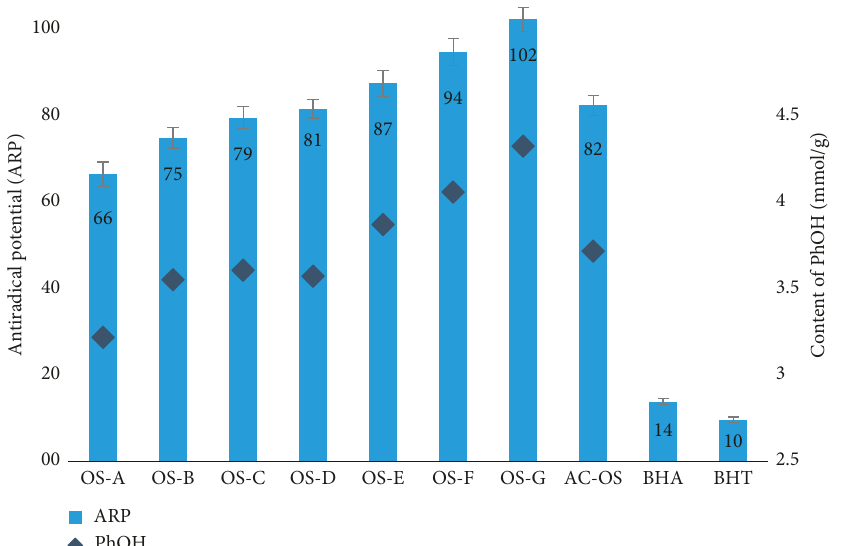
Figure 3: Relationship between antiradical potential and content of phenolic hydroxyl groups; ARP is reported as mean ( n error bars represent the standard